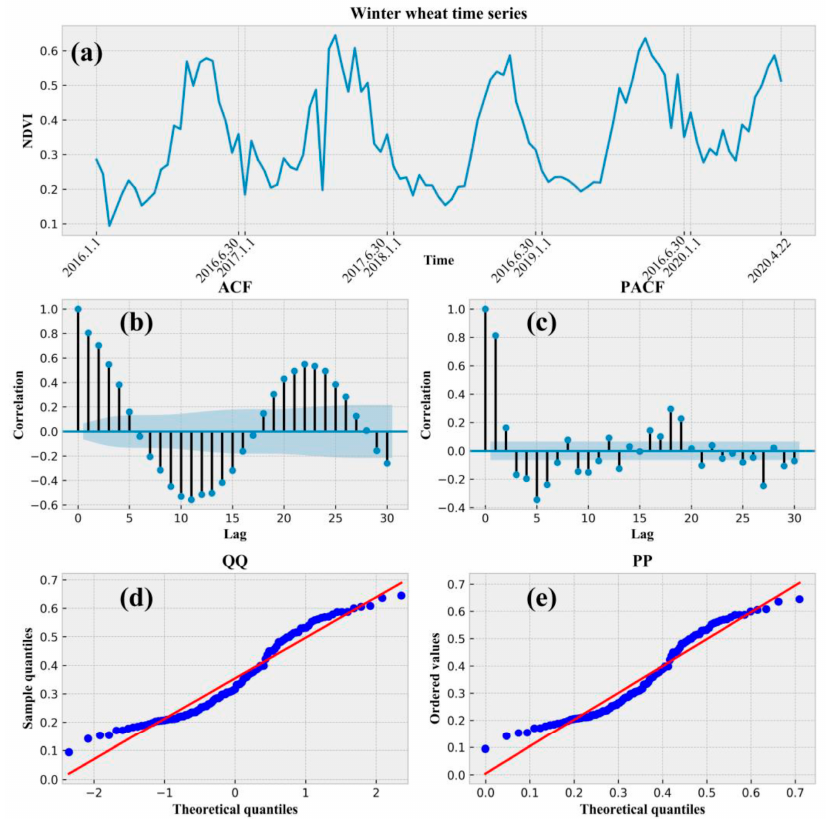
Figure 5. Statistical characteristics of the winter wheat time series. ( a ) The original winter wheat time series. ( b ) Autocorrelation function (ACF). ( c ) Partial autocorrelation function (PACF). ( d ) Quantile–quantile plot (QQ). ( e ) Probability–probability plot (PP).